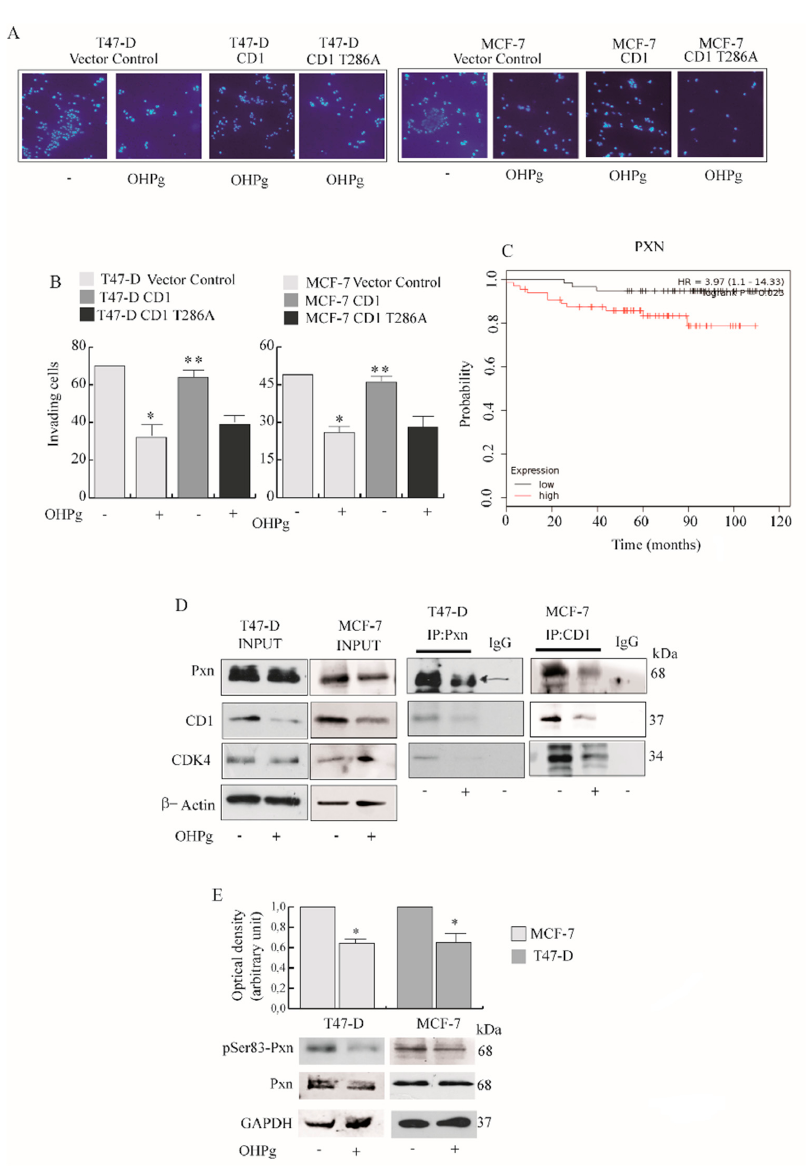
Figure 5. OHPg effects on CD1/Cdk4/Paxillin (Pxn) interaction and Pxn phosphorylation. ( A ) Transmigration assay, ( B ) Invasion assay. Cells were co-transfected with vector control, CD1 or phosphorylation site mutant of CD1 (CD1 T286A) expression plasmids. Columns are the mean of three independent experiments each in triplicate; bars, SD; * p ≤ 0.05 vs. vehicle treated vector control cells. ** p ≤ 0.05 vs. OHPg-treated vector control cells ( C ) Kaplan–Meier distant metastasis-free survival analysis in luminal A PR+ breast carcinoma patients ( n = 122) with high and low Pxn expression analyzed as described in the Materials and Methods. Kaplan-Meier survival graph, and hazard ratio (HR) with 95% confidence intervals and logrank p value ( D ) Co-immunoprecipitation analysis (right panel). Cytoplasmic extracts were immunoprecipitated with anti-Pxn or anti-CD1 antibodies, as indicated, and immunoblotted with anti-Pxn, anti-CD-1 and anti-Cdk4. Input (left panel), samples without immunoprecipitation. β Actin, loading control. IgG was used as the negative control. ( E ) Immunoblotting for pSer83 Pxn and Pxn expression in T47-D and MCF-7 cells, as indicated. GAPDH, loading control. Columns indicate the mean of relative ratio pSer83 vs. total Pxn. * p ≤ 0.05 vs. vehicle-treated cells.